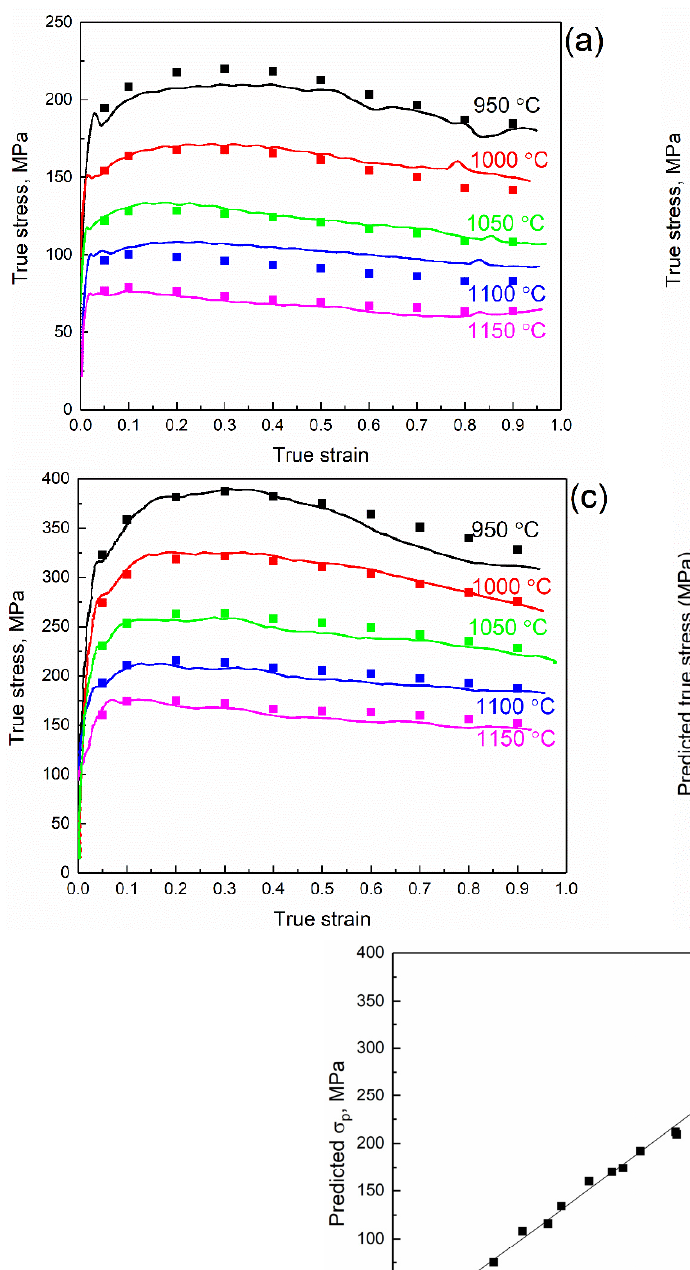
Figure 7. The calculated true stress values in the case of the changing of the temperature at a constant strain rate of 1 s − 1 ( a ) and in the case of the changing of the strain rate at the same temperature profile ( b ). 3.3. Microstructure Evolution during the Hot Deformation The hot deformation significantly influenced the grain microstructure of the investi- gated steel (Figure 8). The deformation at temperatures higher than 1050 °C provides a fully recrystallized microstructure in contrast with the microstructure after the defor- mation at a lower temperature that consists of a large initial unrecrystallized grains and small DRX grains (Figure 9). The DRX grain size increases with increases in the tempera- ture and decreases in the strain rate (Figure 10a). The grain after the deformation at 1050 °C and 10 s − 1 refines more than ten times in comparison with the initial value. At lower temperatures, the DRX process did not finish, and we can see in the microstructure elon- gated coarse initial grains and groups of fine crystallites. The values of the dynamically recrystallized grains obtained at the temperatures of 1050–1150 °C were used to construct the microstructure evolution during the DRX. The